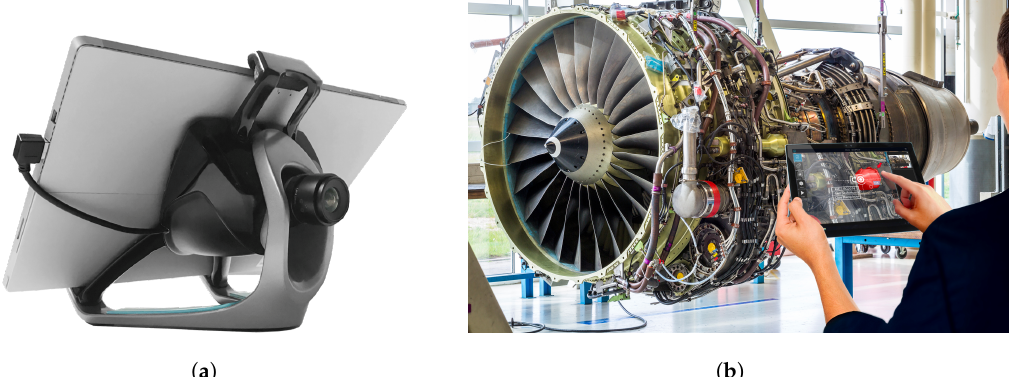
Figure 3. Tablet-based interface equipped with a camera for visual inspection. ( a ) the tablet-based interface equipped with a camera ( b ) the tablet-based handheld interface used by an operator for the inspection of an aircraft